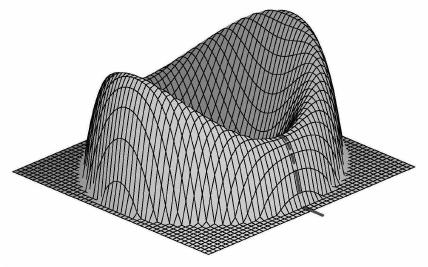
Figure 2. A typical mountain